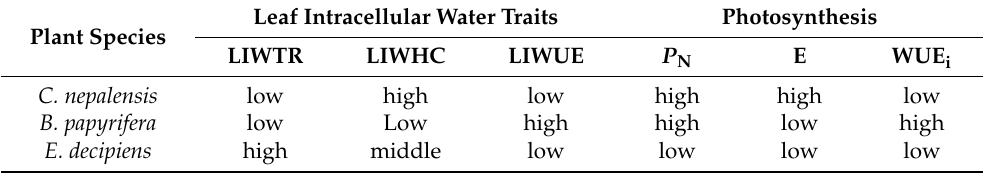
Table 3. Differences among intracellular water use (leaf intracellular water transport rate (LIWTR), water-holding capacity (LIWHC), and water-use efficiency (LIWUE)) and photosynthesis (net pho- tosynthetic rate ( P N ), transpiration rate (E), and instantaneous water-use efficiency (WUE i )) in C. nepalensis, B. papyrifera , and E. decipiens . Leaf Intracellular Water Traits Photosynthesis Plant Species LIWTR LIWHC LIWUE P N WUE